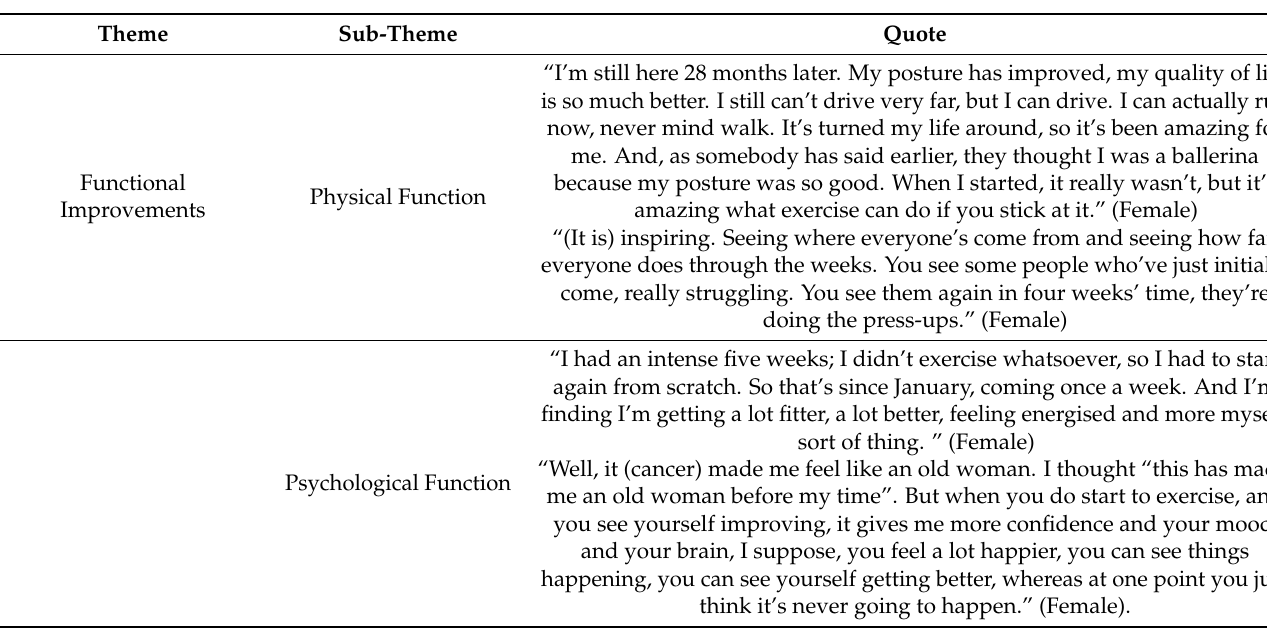
Table 6. Overall Effectiveness themes, sub-themes and participant quotes related to their experience of